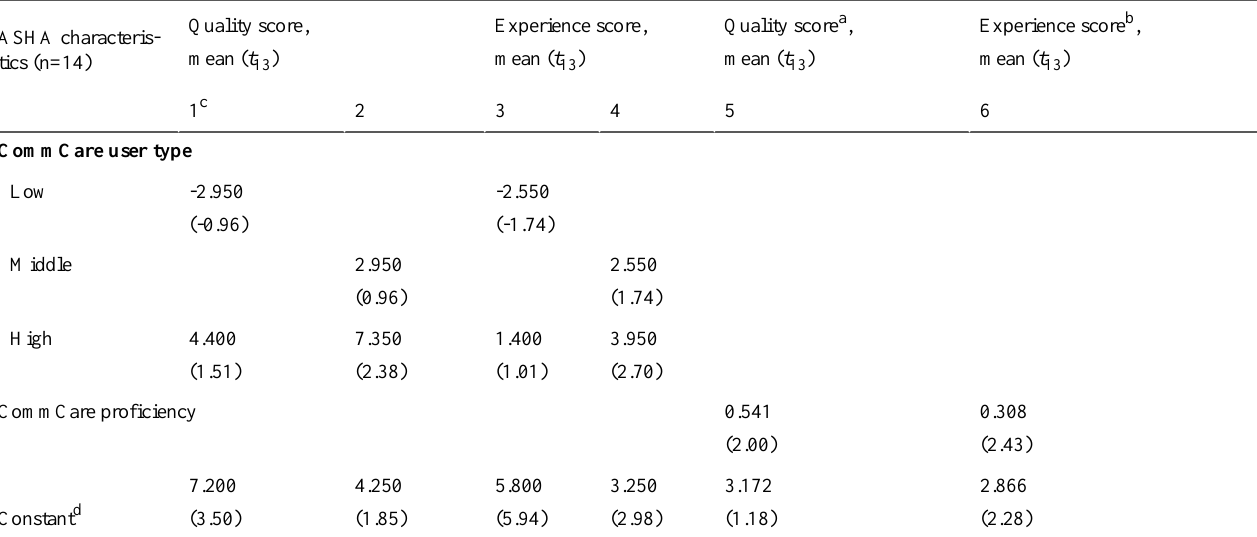
Table 7. Relationship between CommCare adoption and quality and experience of